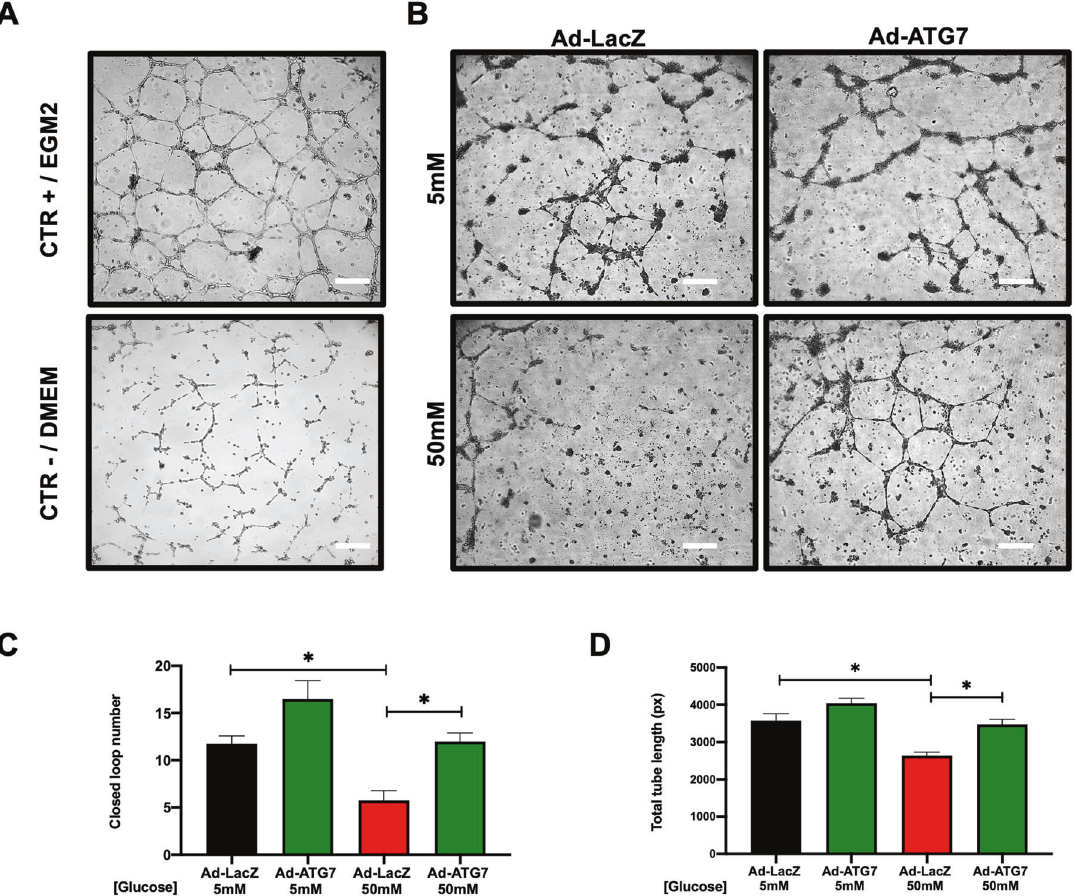
Fig. 7 Autophagy induction enhances the pro-angiogenic paracrine capacity of CSCs. Tube-forming assay was performed with HUVECs exposed to conditioned media from ad-ATG7 or ad-LacZ transduced CSCs, in 5 or 50 mM glucose. Representative culture images are shown ( A , B ), together with the quanti fi cation of closed-loop number (C) and total tube length (D) ( n = 4). Scale bars = 200 µm.